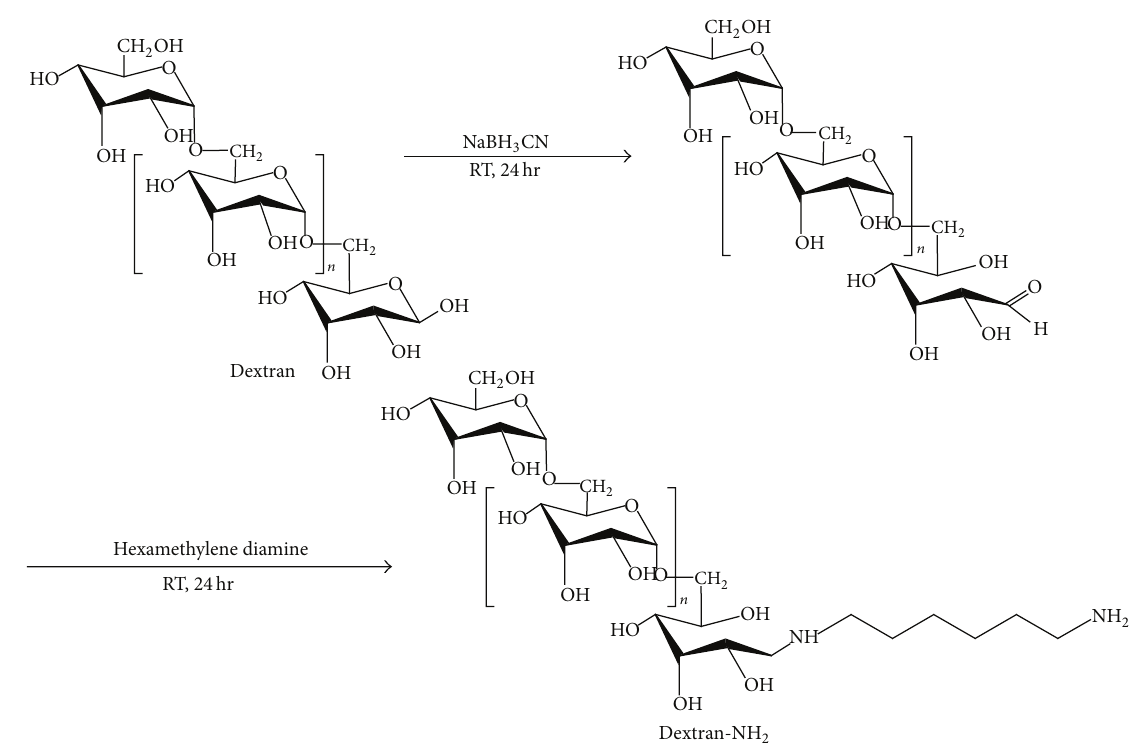
Figure 1: Synthesis scheme of dextran-hexamethylene diamine